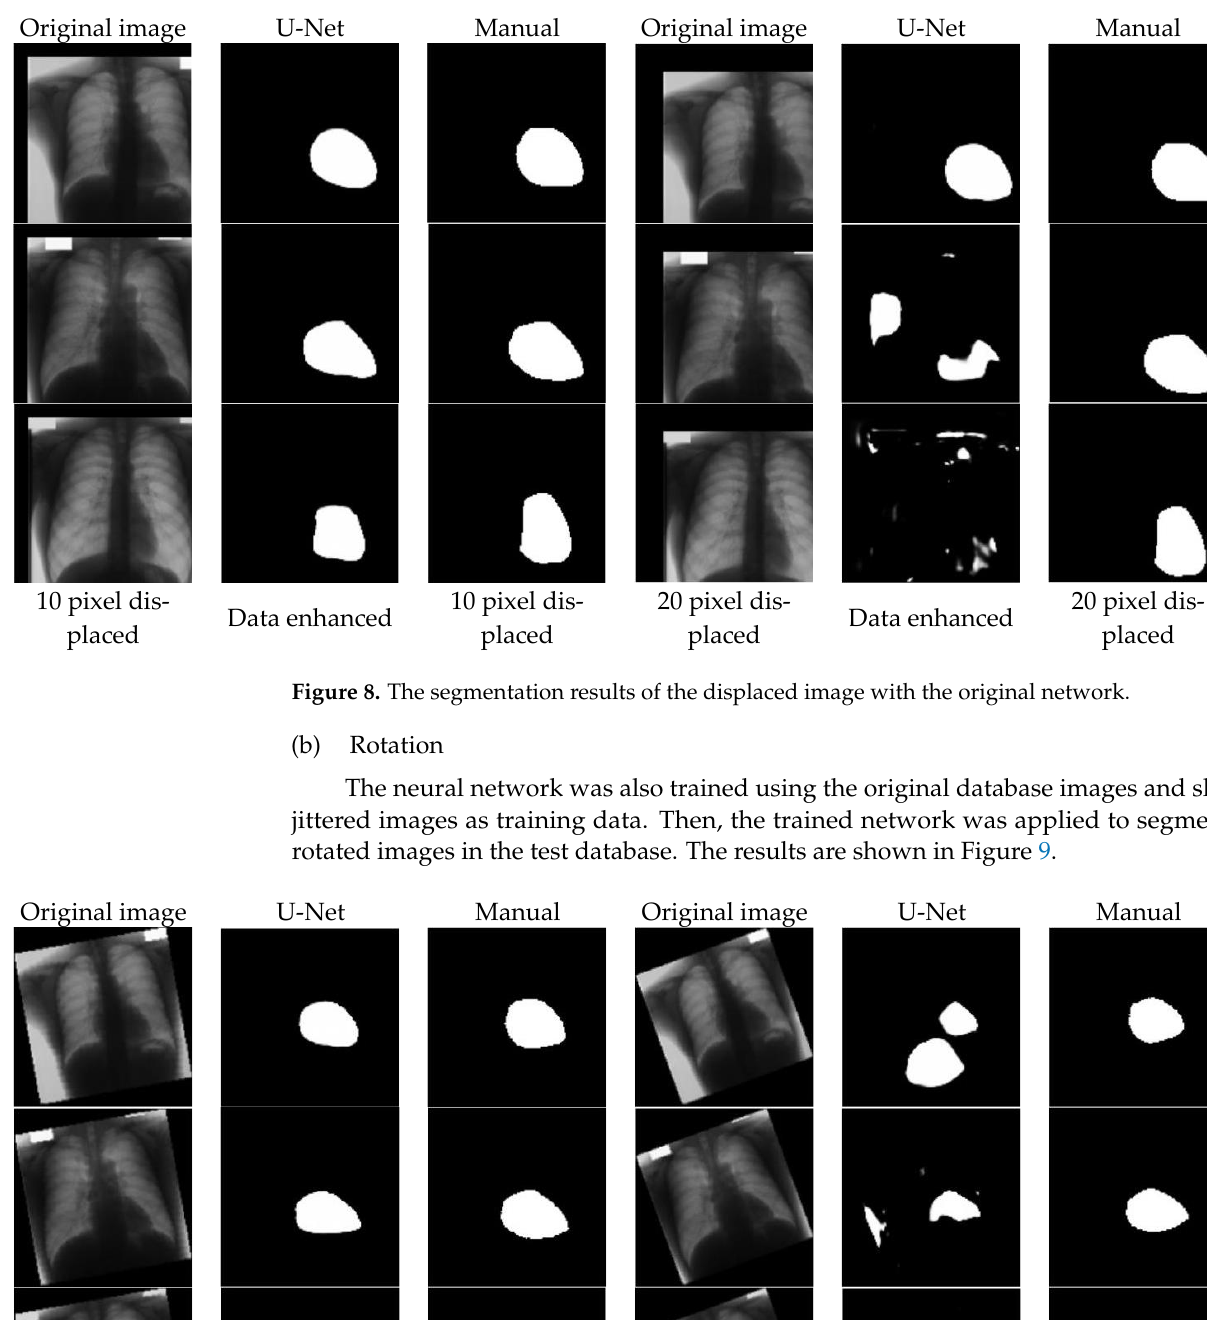
Figure 9. The segmentation results of the rotated image with the original network.